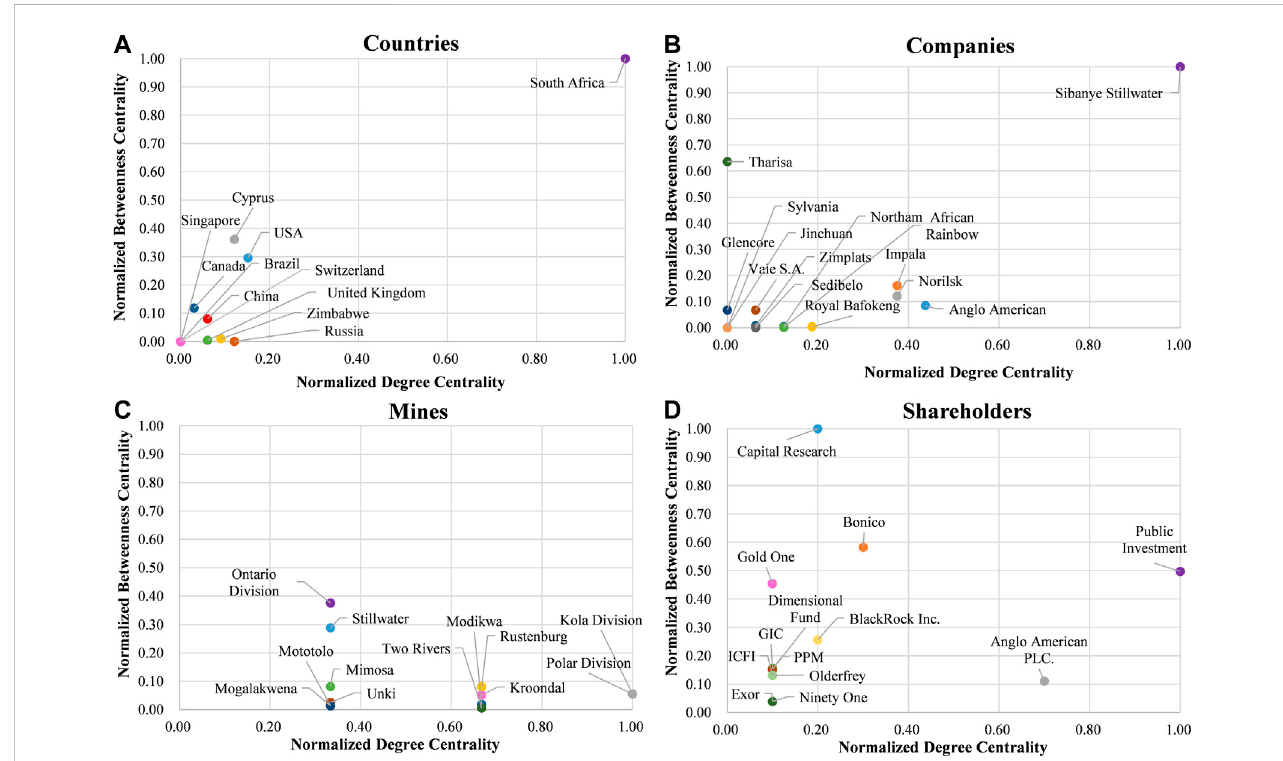
The betweenness centrality of various supply subjects in the global platinum supply network: (A) The betweenness centrality of countries, (B) The betweenness centrality of companies, (C) The betweenness centrality of mines, (D) The betweenness centrality of